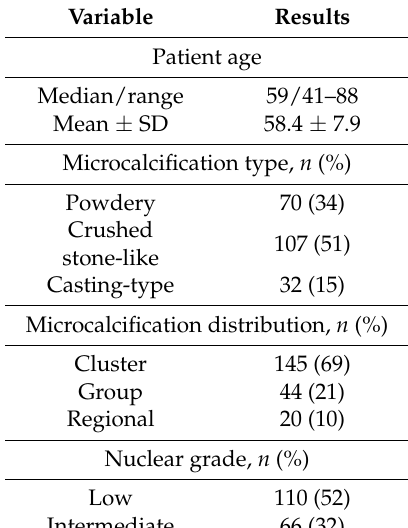
Table 1. Baseline